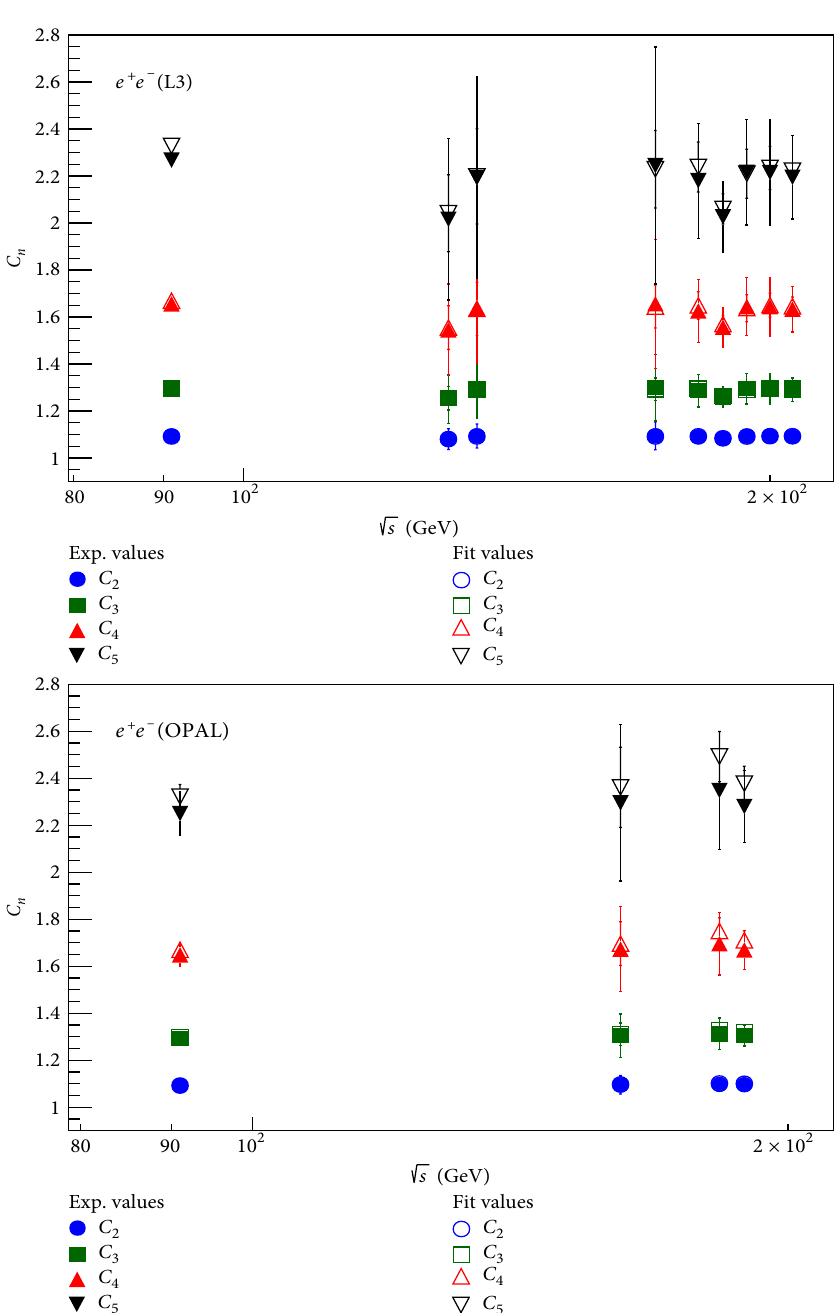
Figure 5: Normalized moments of modified shifted Gompertz distribution for the at different